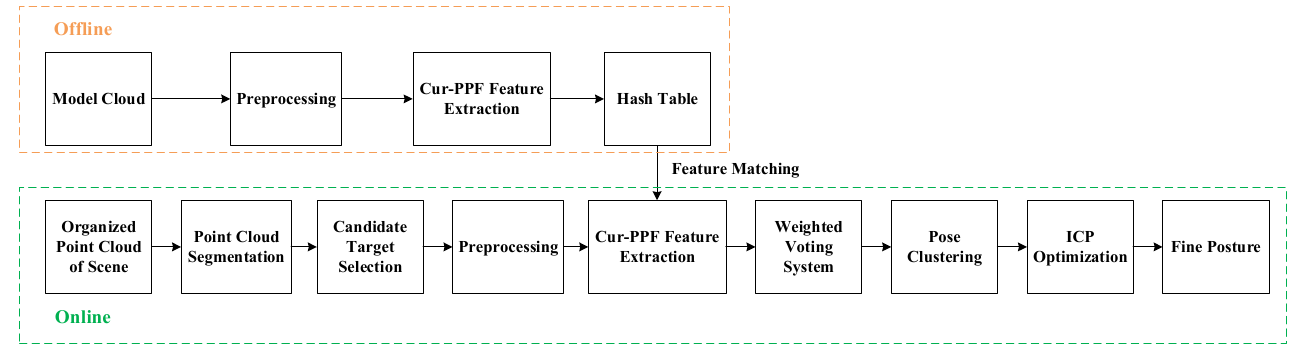
Figure 1. The full point-pair feature with curvature pipeline. The proposed method can be divided into offline stage and online stage.